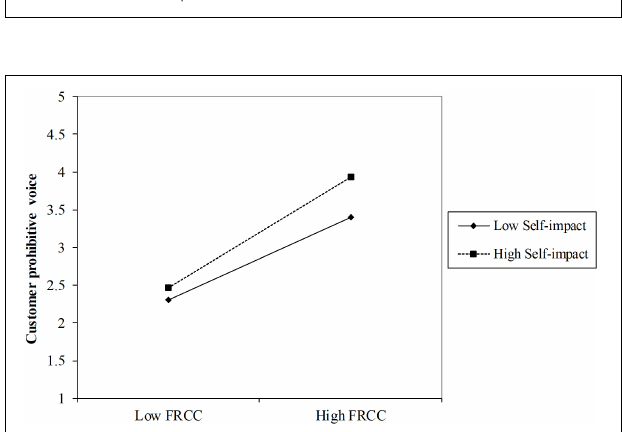
confirmed that customers with higher personal self-impact would be more motivated to exhibit positive voice